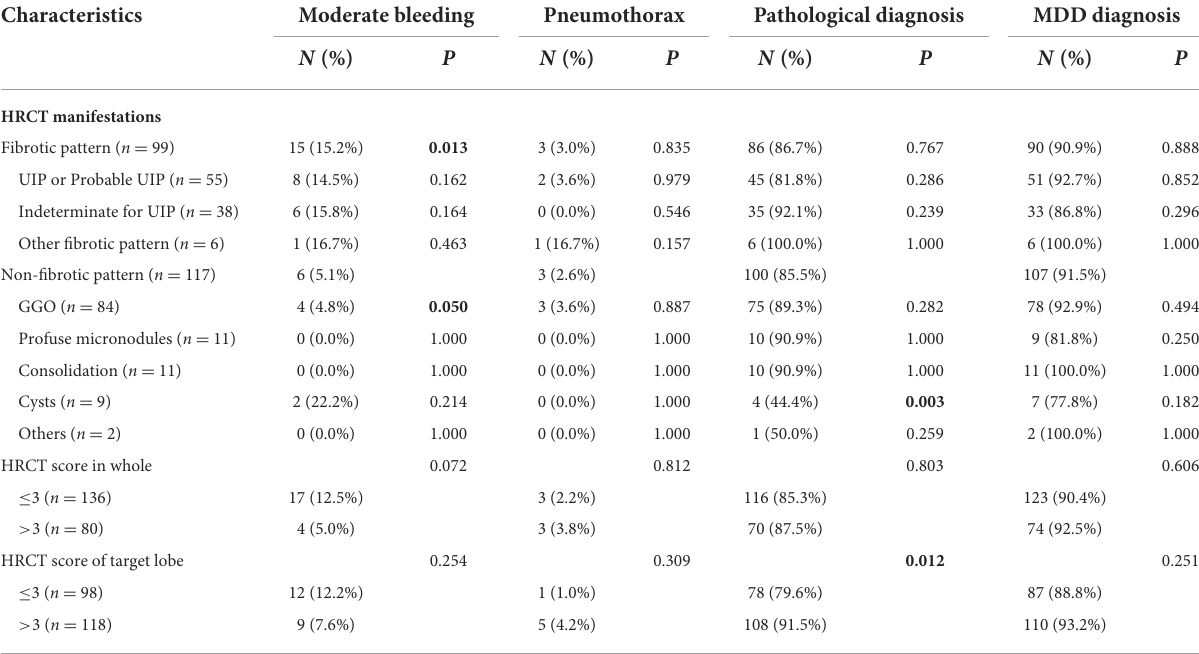
TABLE 3 The safety profile and diagnostic efficacy of transbronchial cryobiopsy (TBCB) in patients with different HRCT features. Characteristics Moderate bleeding Pneumothorax Pathological diagnosis